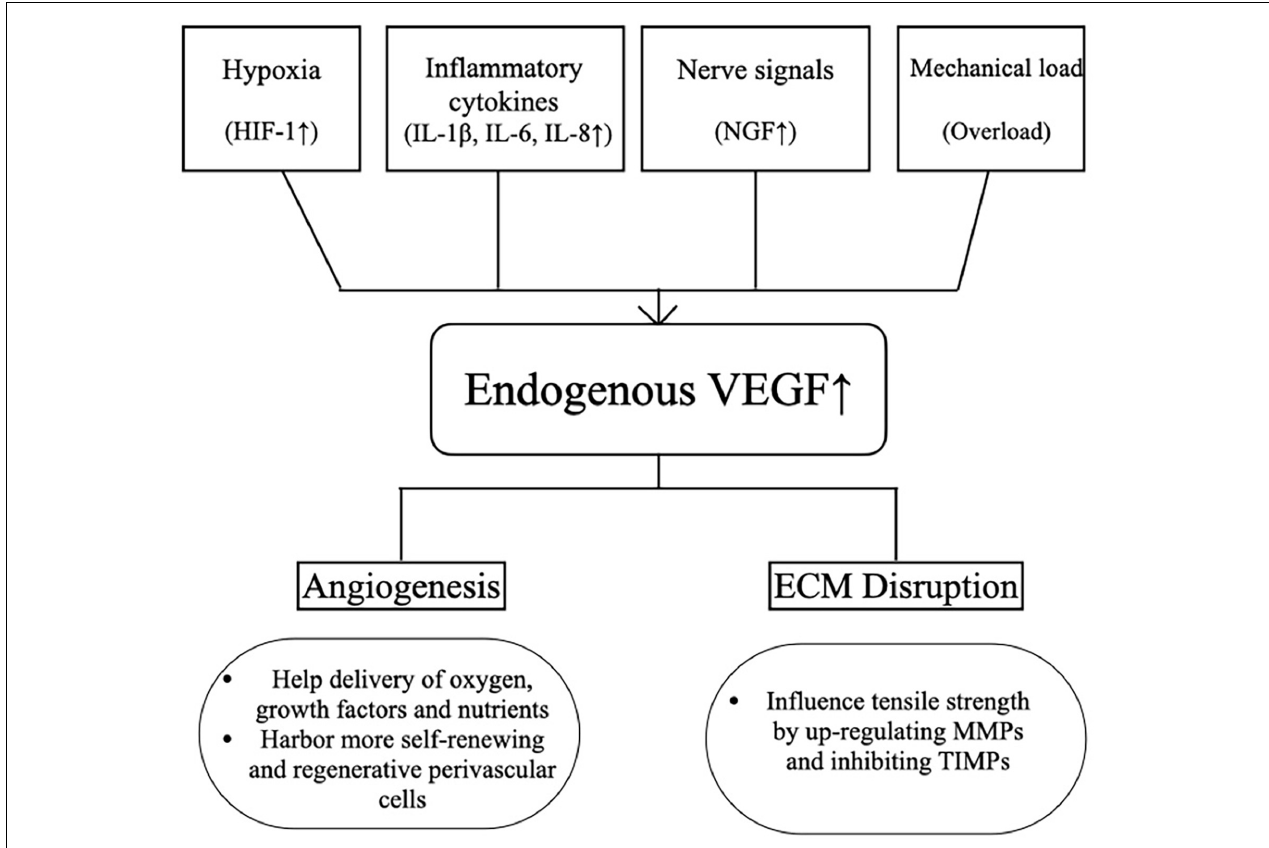
FIGURE 3 | The main factors for endogenous VEGF upregulation and two paradoxical roles for VEGF in tendons. HIF-1, hypoxia-inducible factor-1; IL-1 β , interleukin-1 β ; IL-6, interleukin-6; IL-8, interleukin-8; VEGF, vascular endothelial growth factor; ECM, extracellular matrix; MMP, matrix metalloproteinase; TIMP, tissue inhibitor of